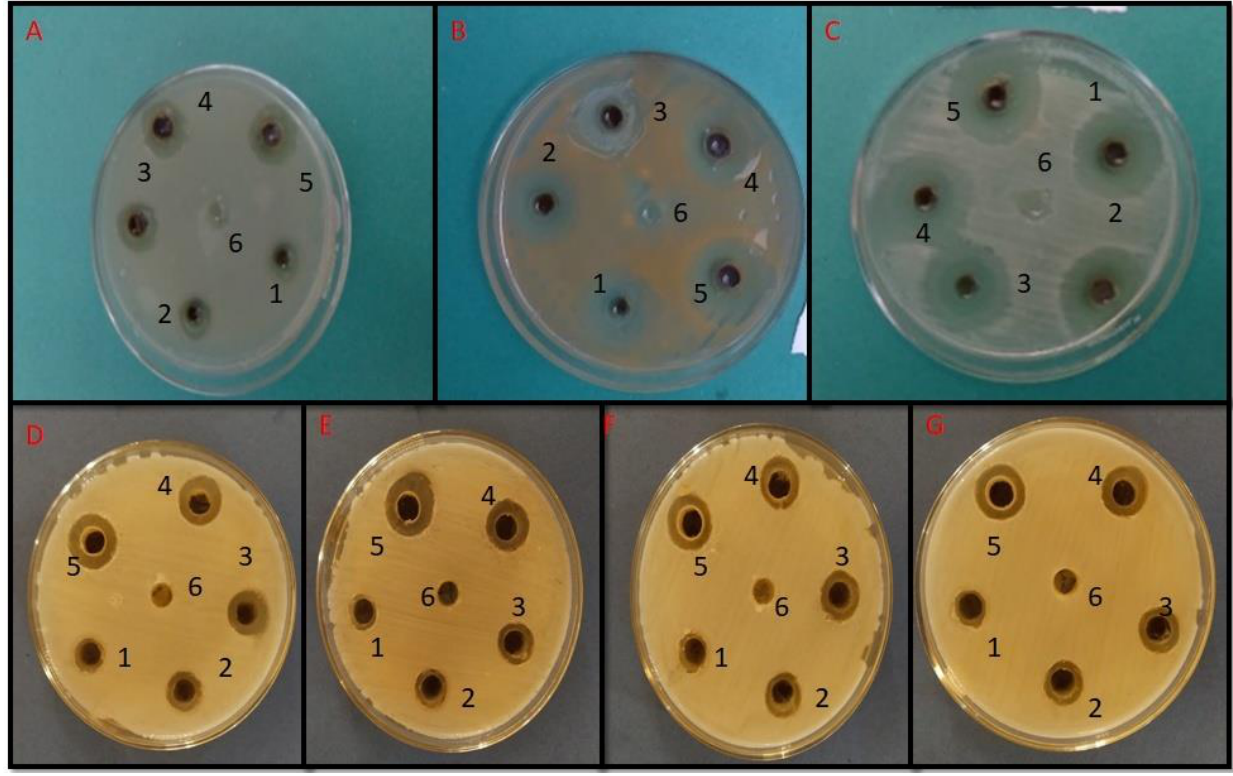
Figure 6. Well diffusion assay representative of ( A ) K. pneumonia, ( B ) S . aureus, ( C ) E . coli, ( D ) C. albicans , ( E ) C . tropicalis, ( F ) C . dubliniensis, ( G ) C. parapsilosis. 1 = 31.25 µg/mL, 2 = 62.5 µg/mL, 3 = 125 µg/mL, 4 = 250 µg/mL, 5 = 500 µg/mL, 6 = control (distilled water).